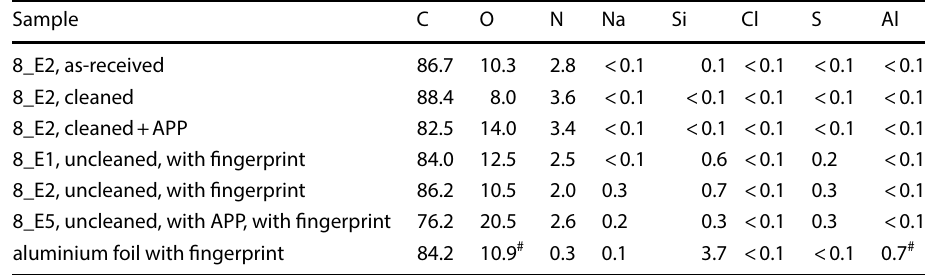
aluminium foil with fingerprint